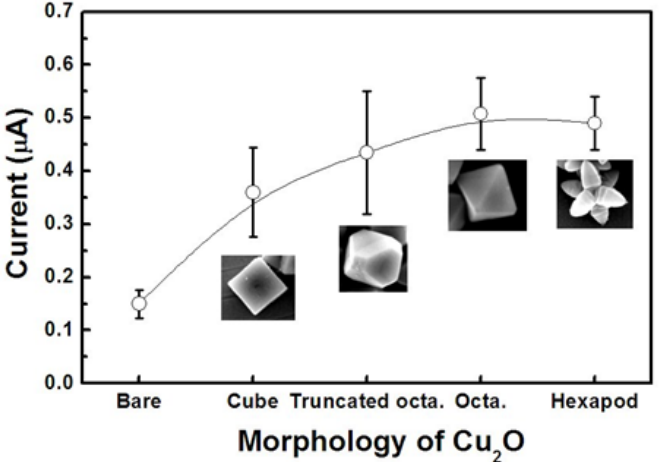
Figure 7. Amperometric responses of electrodes coated with Cu morphologies in 0.1 M PBS containing 5 mM [Fe(CN) in the presence of 5 mM